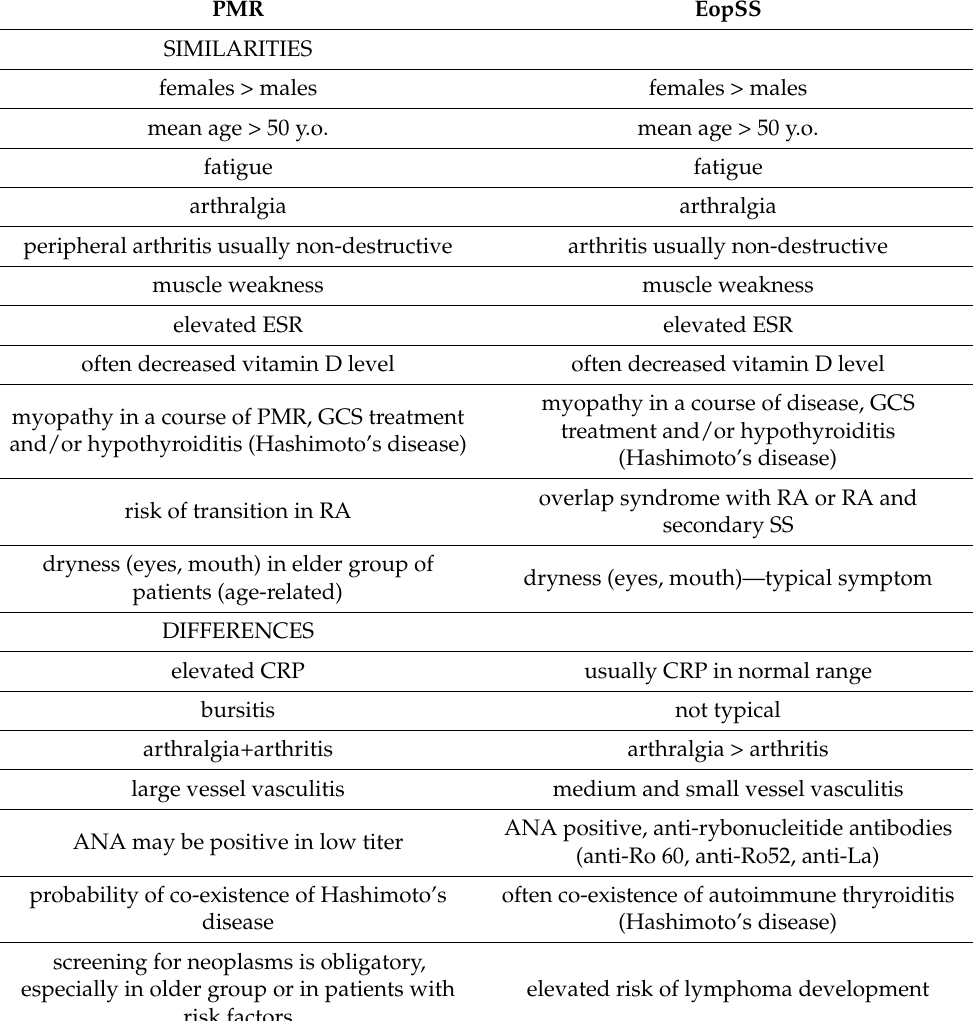
Table 2. PMR and EopSS: similarities and